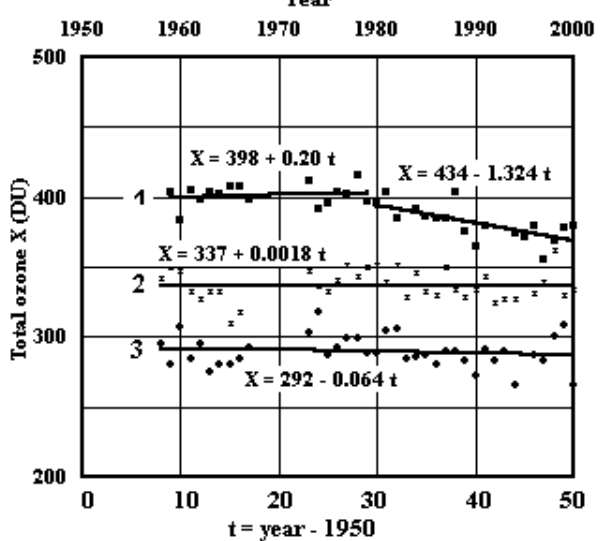
Fig. 7. Trend lines of total ozone X 1958–2000: t – years from 1958; 1 – winter/spring (Feb.–Apr.), 2 – summer (June–Aug.), 3 – late autumn (Oct.–Nov.).